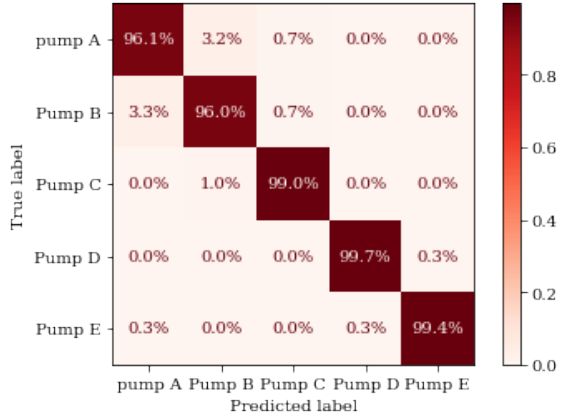
Figure 9. FDI evaluation: Confusion matrix.